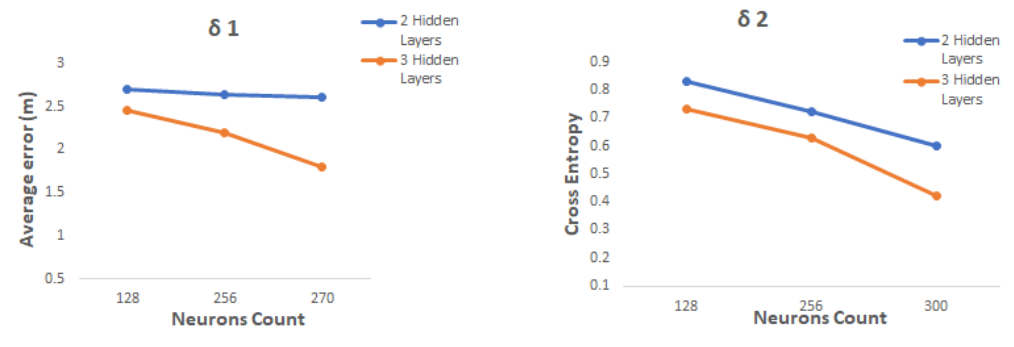
Figure 11. The number of hidden layers and neurons vs. each loss